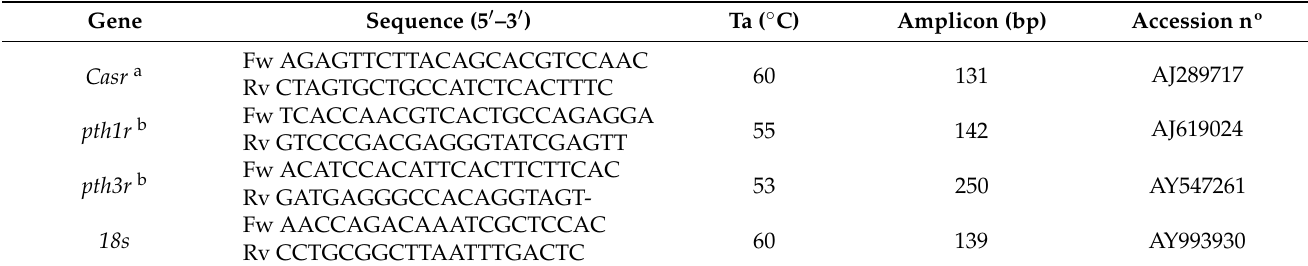
Table 1. Details of primers used for